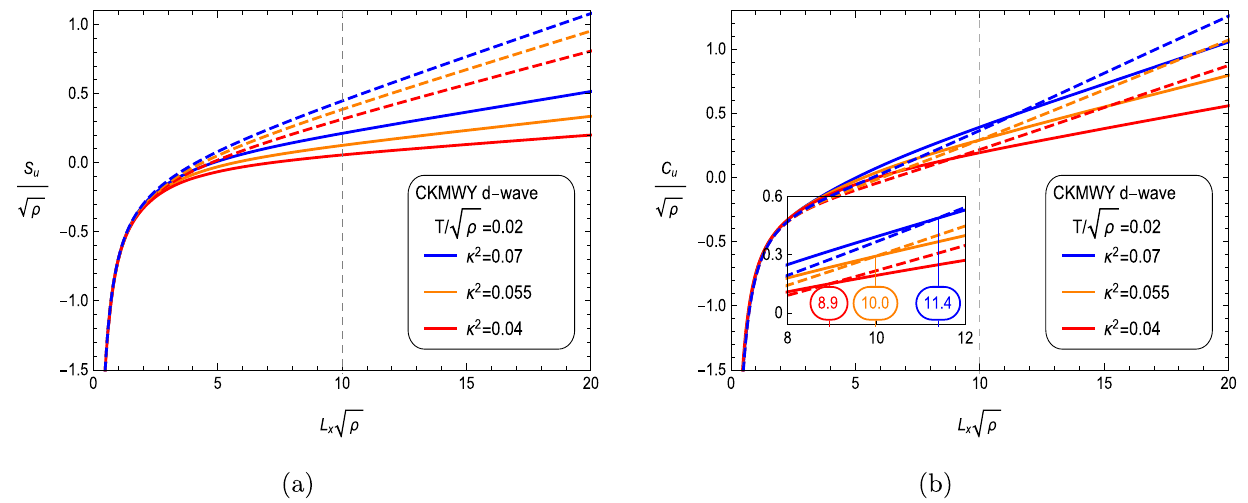
√ ρ for the CKMWY d-wave superconductor with a fixed temperature T :